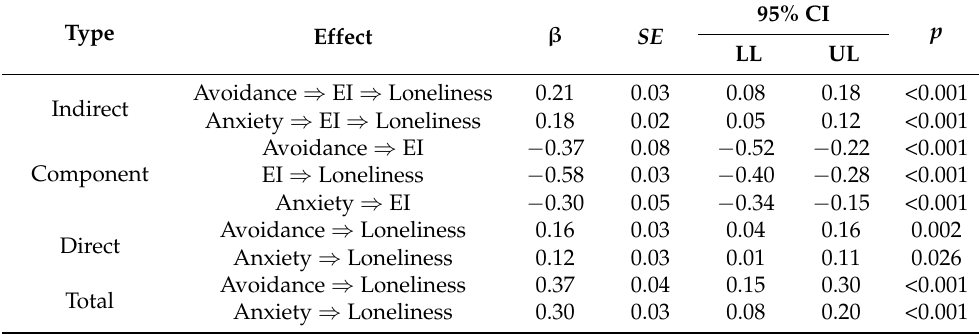
Table 5. Mediation analysis for Study 1.